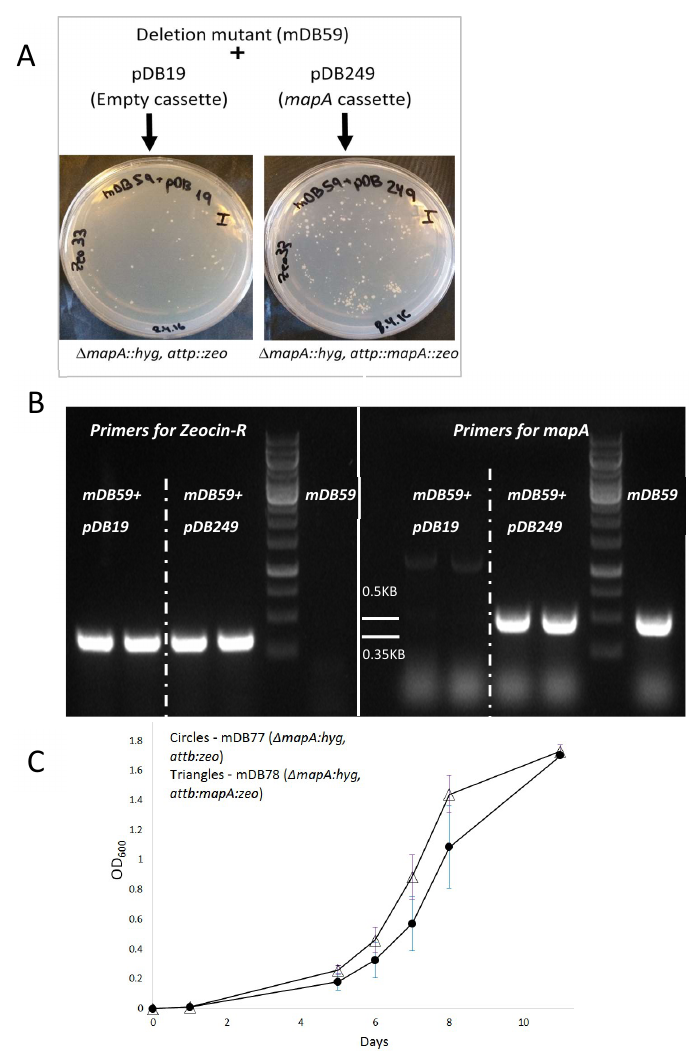
Figure 2. Complete mapA deletion mutant. ( A ) Electroporation of mDB59 with either pDB19 or pDB249 (exchanging mapA-Kan for null-zeocin or mapA-zeocin , respectively) both yielded multiple colonies. ( B ) Two random colonies from each electroporation were analyzed by PCR. All four colonies became zeo-R positive (left panel, zeo-R product is 0.35KB), confirming cassette exchange, however only mDB59 + pDB249 remains positive for mapA (Right, expected PCR product of 0.5KB). Both mDB59 + pDB19 colonies are complete mapA deletion mutants. ( C ) A complete mapA deletion mutant (mDB77) has a mild growth defect in 7H9 media during the exponential phase of growth as compared to mDB78, however it reaches the same final OD (done in duplicates, one of two similar experiments is shown).